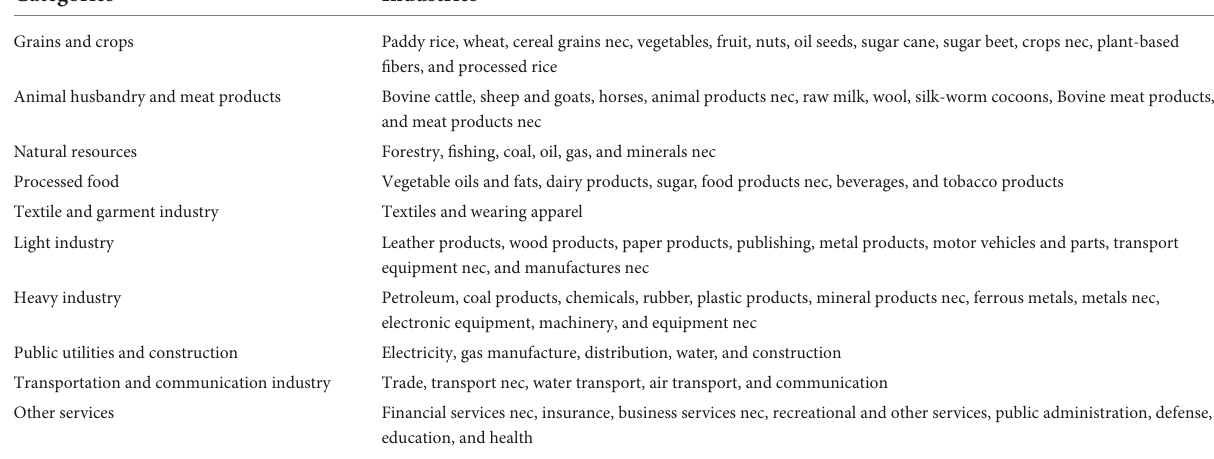
TABLE 1 Classification of